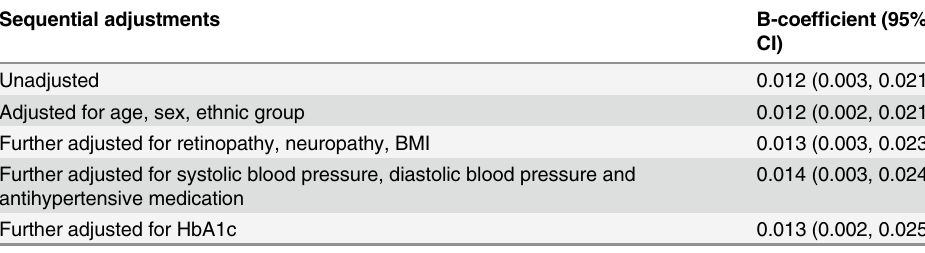
Table 3. Linear regression analysis of the association between cognitive impairment and simple venular tortuosity. Sequential